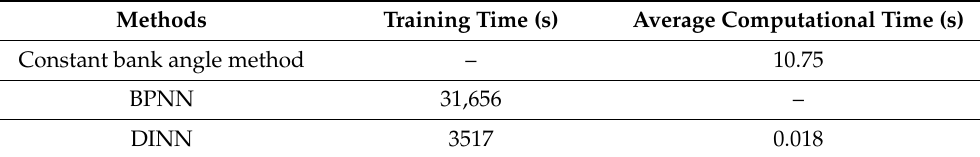
Table 9. Comparison of each method.